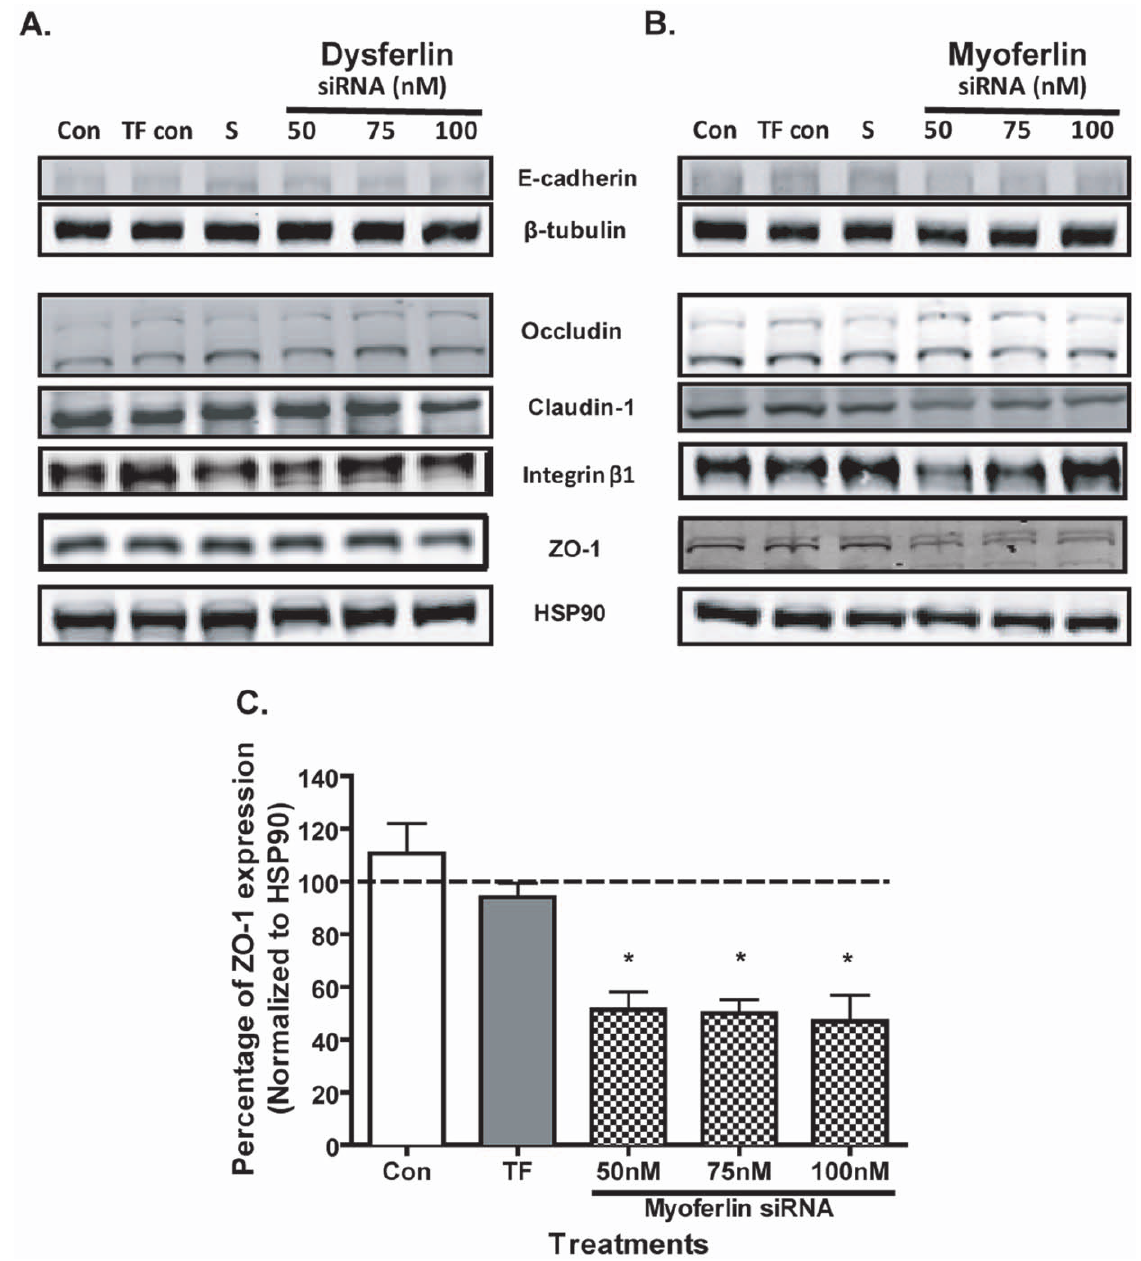
Figure 7. Myoferlin knockdown decreases the expression of tight junction molecule ZO-1. 16HBE cells were treated with control media (con), transfection control (TF con), scrambled siRNA (S), and (A) dysferlin or (B) myoferlin siRNA at 50 nM, 75 nM and 100 nM for 72 h. Total cell lysates were prepared to analyze the expressions of adherens junction molecule E-cadherin and tight junction molecules occludin, claudin 1, zonula occludens-1 (ZO-1) and integrin b 1 as demonstrated by the representative immuno blot from three independent experiments. b -tubulin and HSP90 served as loading controls. (C) Densitometry analysis of band intensities for ZO-1 normalized to HSP90 compared to the scrambled siRNA control (dotted line). Values are represented as mean ( 6 SEM) of three independent experiments. A significant difference between the treatment groups and scrambled siRNA control is indicated by asterisk (* p , 0.05).